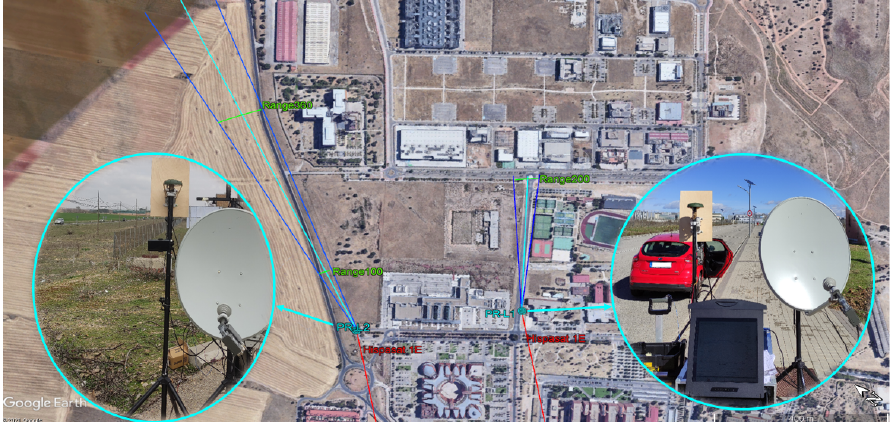
Figure 11. Terrestrial scenarios employed to validate the reflectarray antenna and the PR deployment in each of